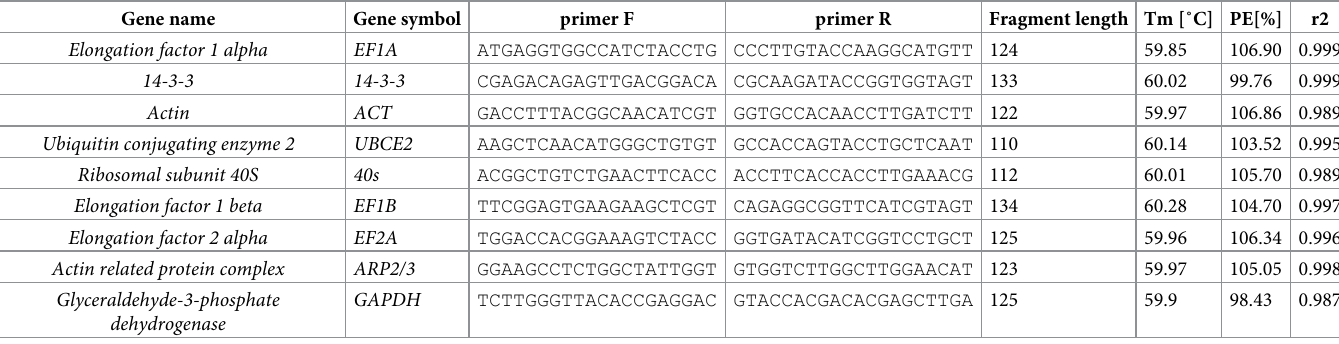
Table 1. Description statistics of housekeeping gene